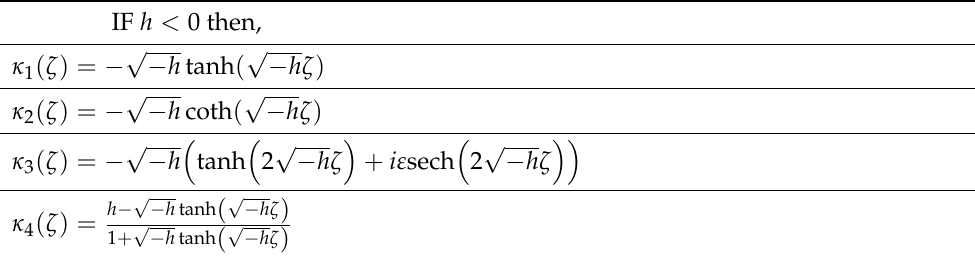
Table 1. Solution functions of κ (cid:48) ( ζ ) = h + [ κ ( ζ )] 2 in Equation (9) [6]. IF h < 0